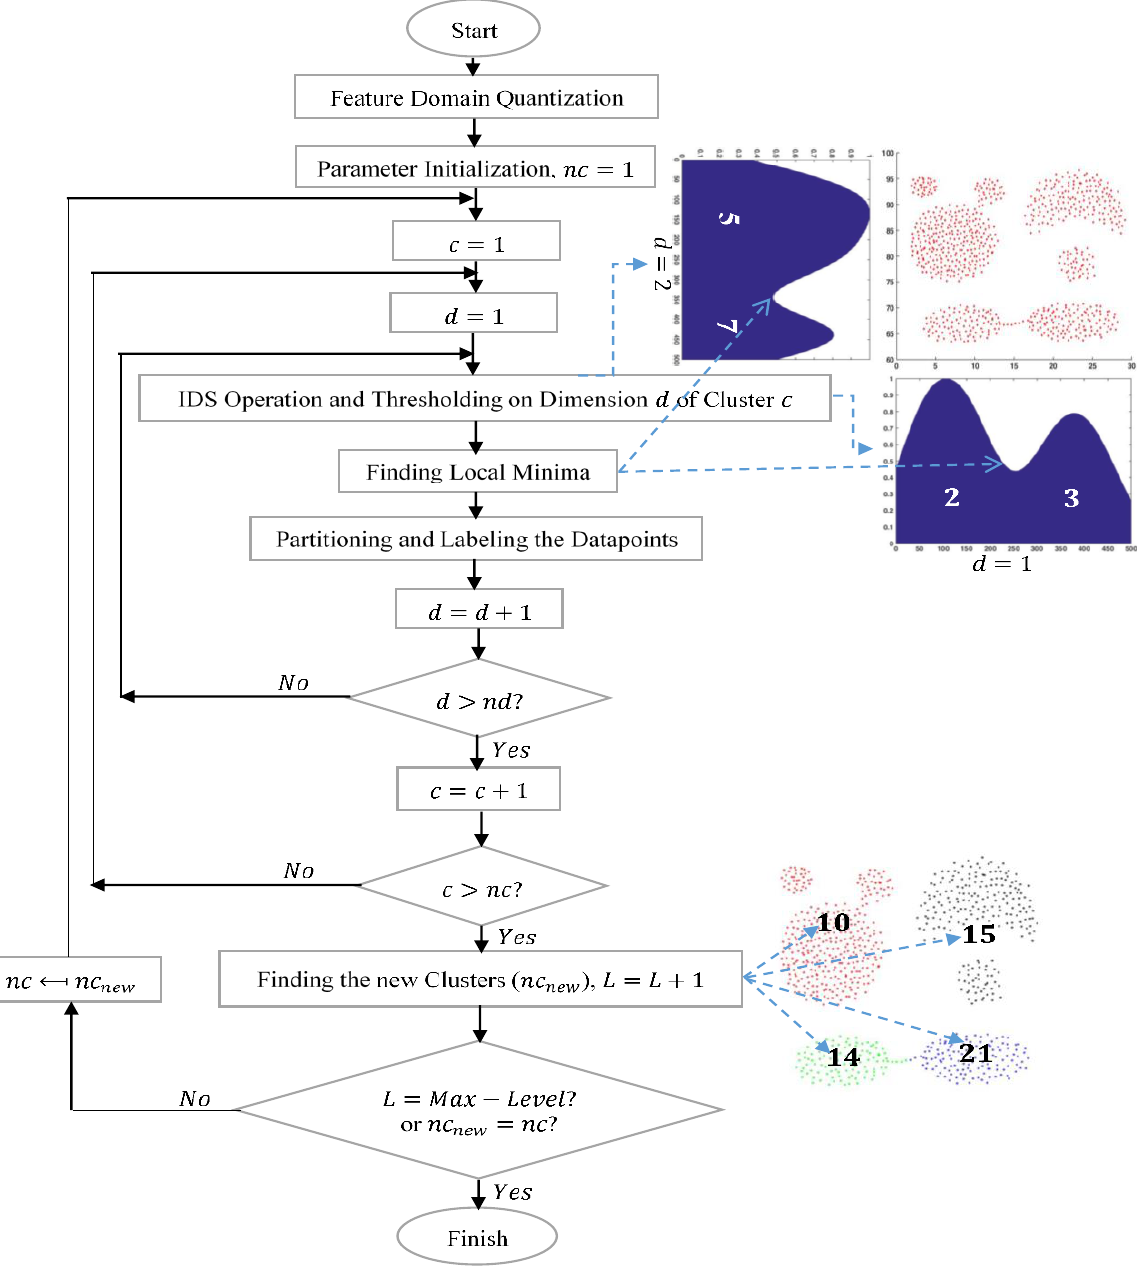
Figure 4. The flowchart of the proposed HUALM clustering algorithm.